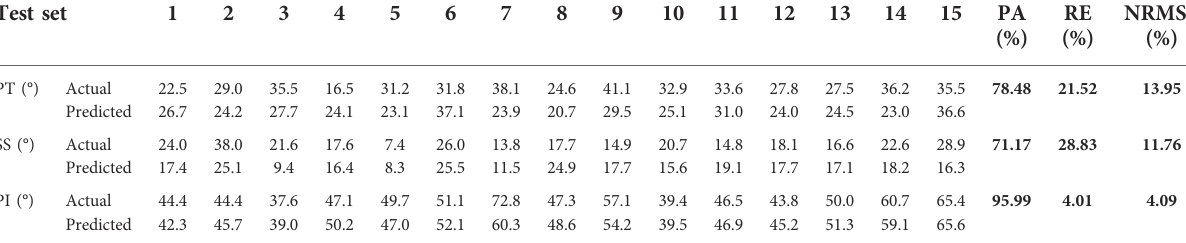
TABLE 3 Predicting sitting PT, SS, and PI based on the BPNN from standing parameters. Test